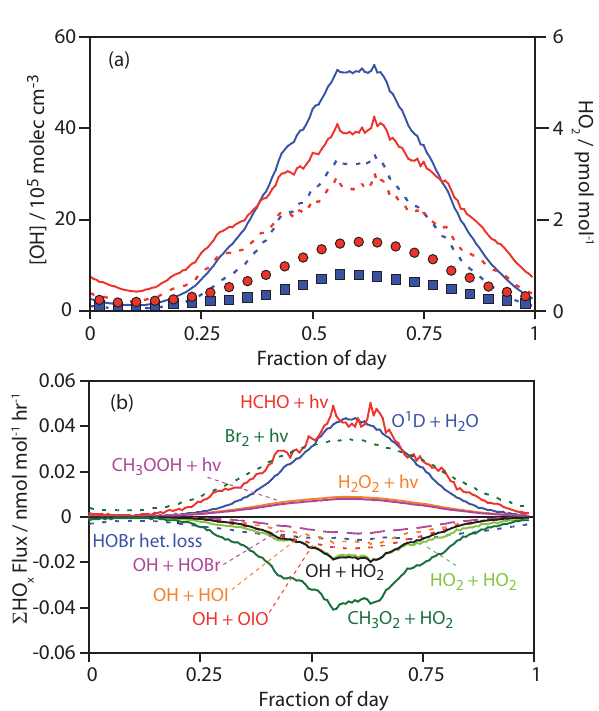
Fig. 6. (a) Observed and modelled mean diurnal OH and HO 2 lev- els. Mean diurnal observed and modelled OH concentrations (blue squares, left axis) and HO 2 mixing ratios (red circles, right axis) together with model simulations for scenarios B2 (solid lines) and C (dotted lines); see text for details. (b) Modelled 6 HO x +BrO x production and removal fluxes. Dotted lines indicate processes in- volving halogen